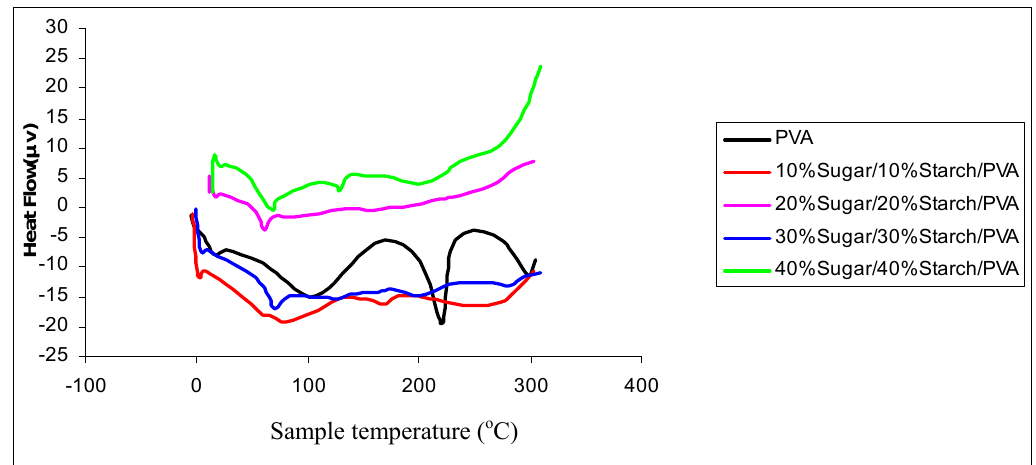
Fig. 4: DSC analysis of PVA, and Starch/PVA/Sugar at different ratio.